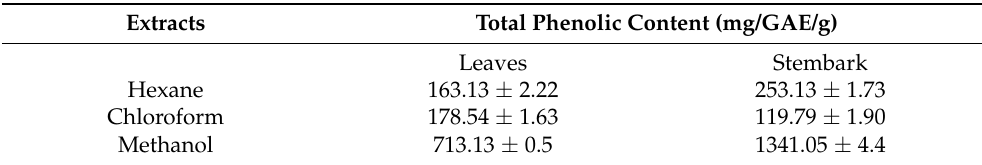
Table 3. Quantification of the total phenolic content of the leaf and stembark extracts (hexane, chloroform and methanol) of C. erythrophyllum